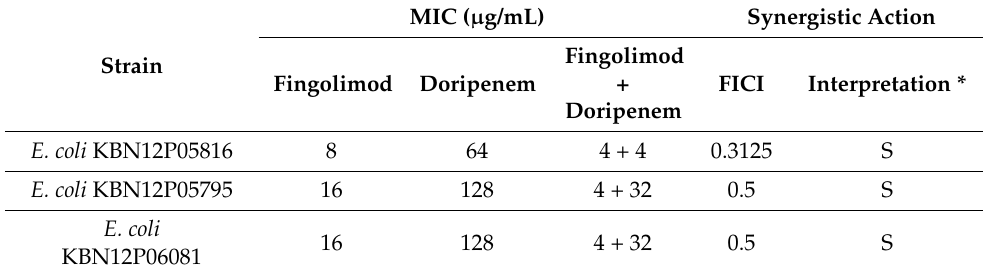
Table 2. Results of the fingolimod and doripenem combination on CREC strains.